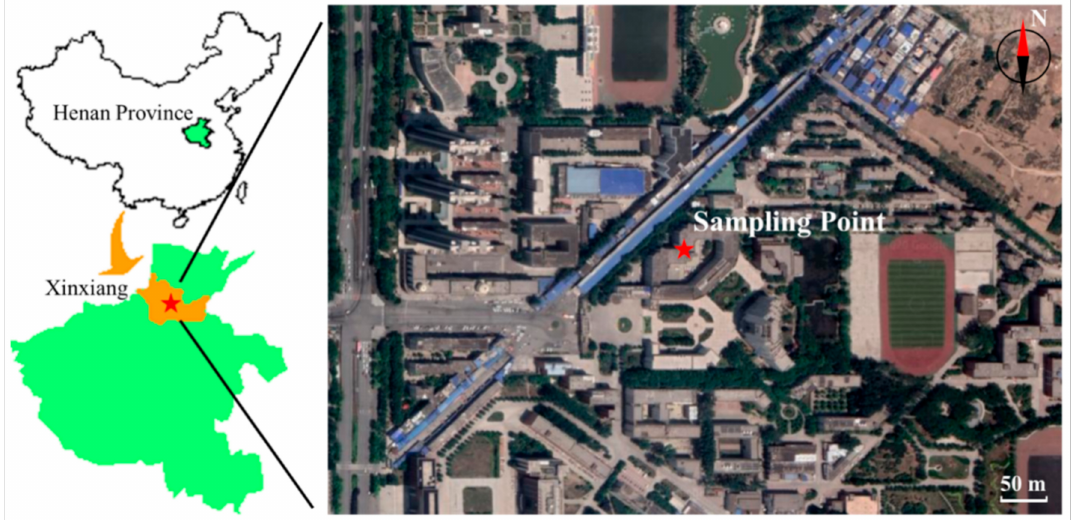
Figure 1. Sampling Point Location Site in Xinxiang,